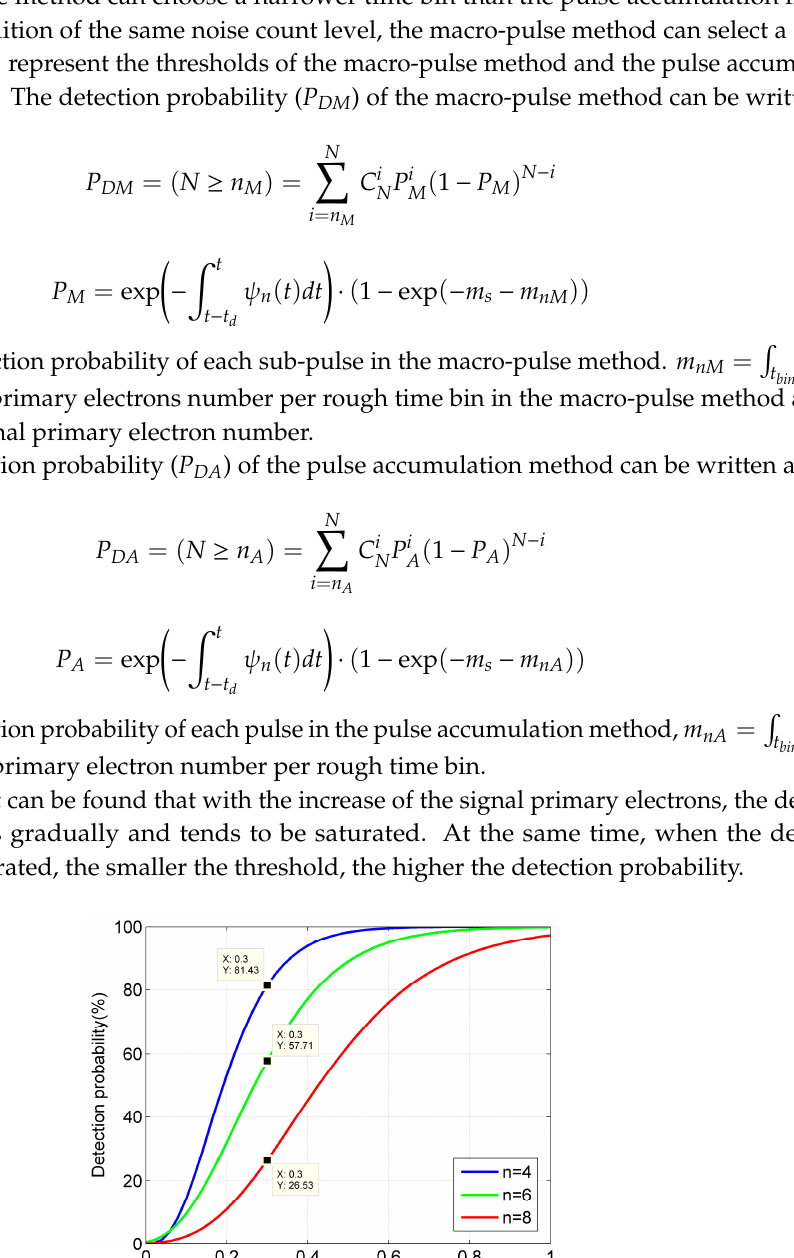
Figure 5. Influence of threshold on detection probability ( N = 20, t d = 50 ns, 1